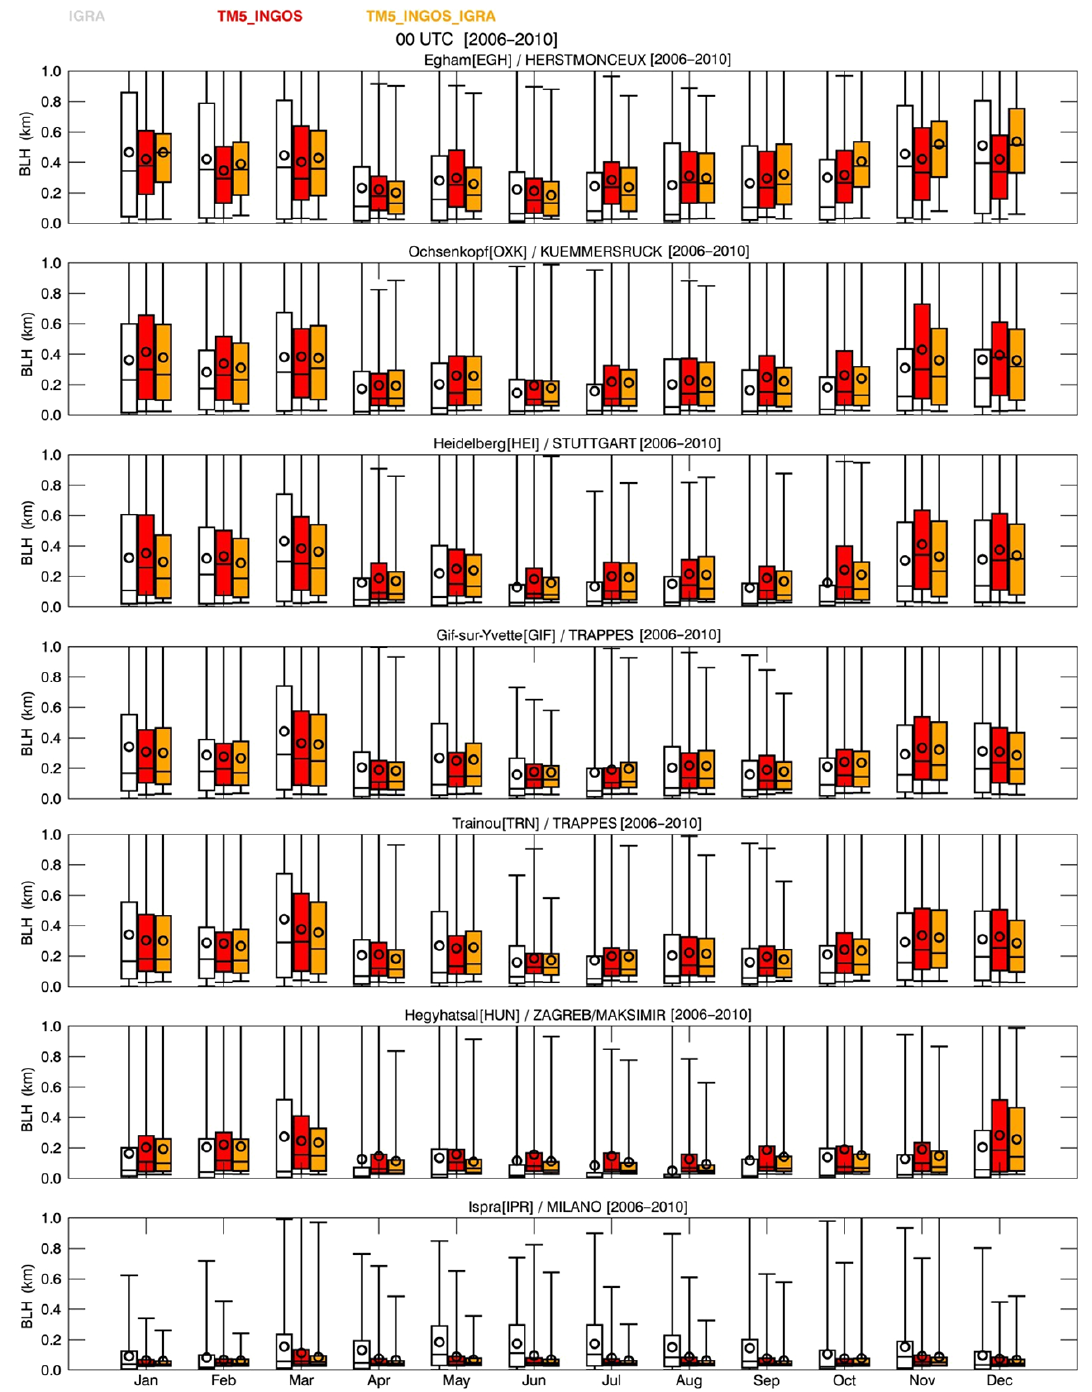
Figure 3. Observed (IGRA; blank) and modelled (TM5_INGOS; red and TM5_INGOS_IGRA; orange) BLHs for InGOS stations at 00:00UTC (2006–2010). The titles of each panel show the names and acronyms of the InGOS station, and the names of the nearest IGRA station used for comparison. The whisker plots show the monthly minimum and maximum values (bars), and the 25 and 75% percentiles (boxes). The median values are given by the horizontal line and the mean values by the open circles in the boxes. The different acronyms of the model data are defined in Sect. 3.2 of the